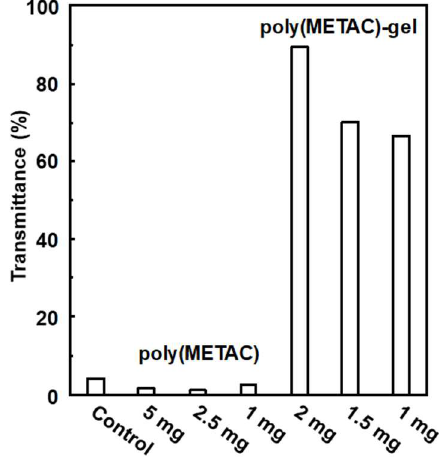
Figure 2. Transmittance measurement of the suspensions of poly(METAC) or poly(METAC)-gel-1.28 with B. subtilis . The B. subtilis suspensions were exposed to poly(METAC) or poly(METAC)-gel-1.28 at different concentrations for 24 h. The total amount of solution was 1.5 mL. After 24 h, the transmittances of supernatants were measured at 500 nm.